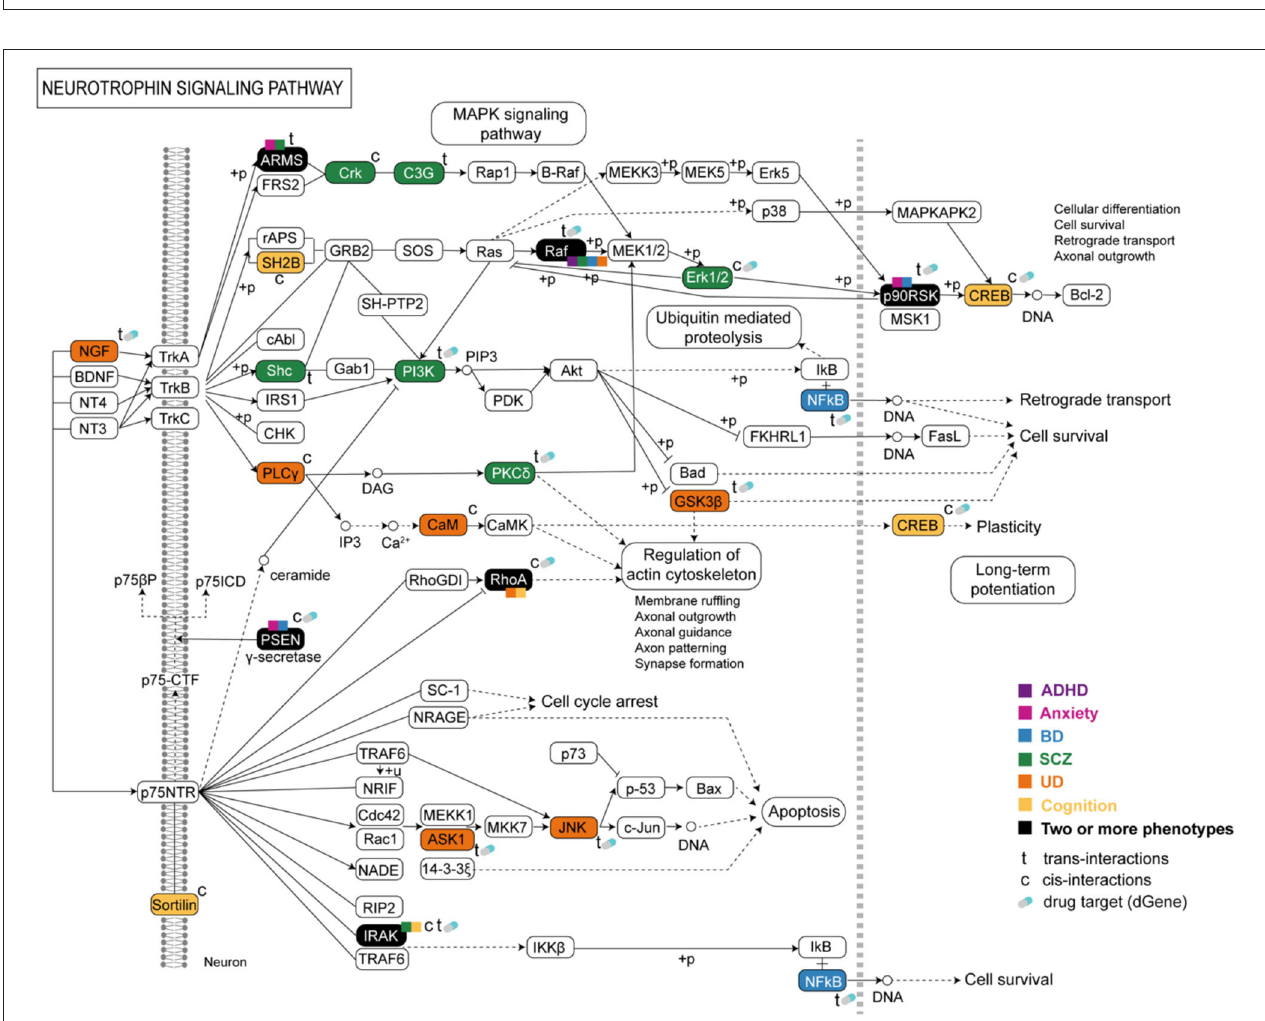
FIGURE 4 | Psychiatric and cognitive SNPs mark eQTLs that are associated with gene expression within the neurotrophin signaling pathway. The co-occurrence of the affected shared or phenotype-specific eGenes and imbalance in gene expression within this pathway may lead to a series of cellular functions and events associated with psychiatric and cognitive phenotypes and the multimorbidities between